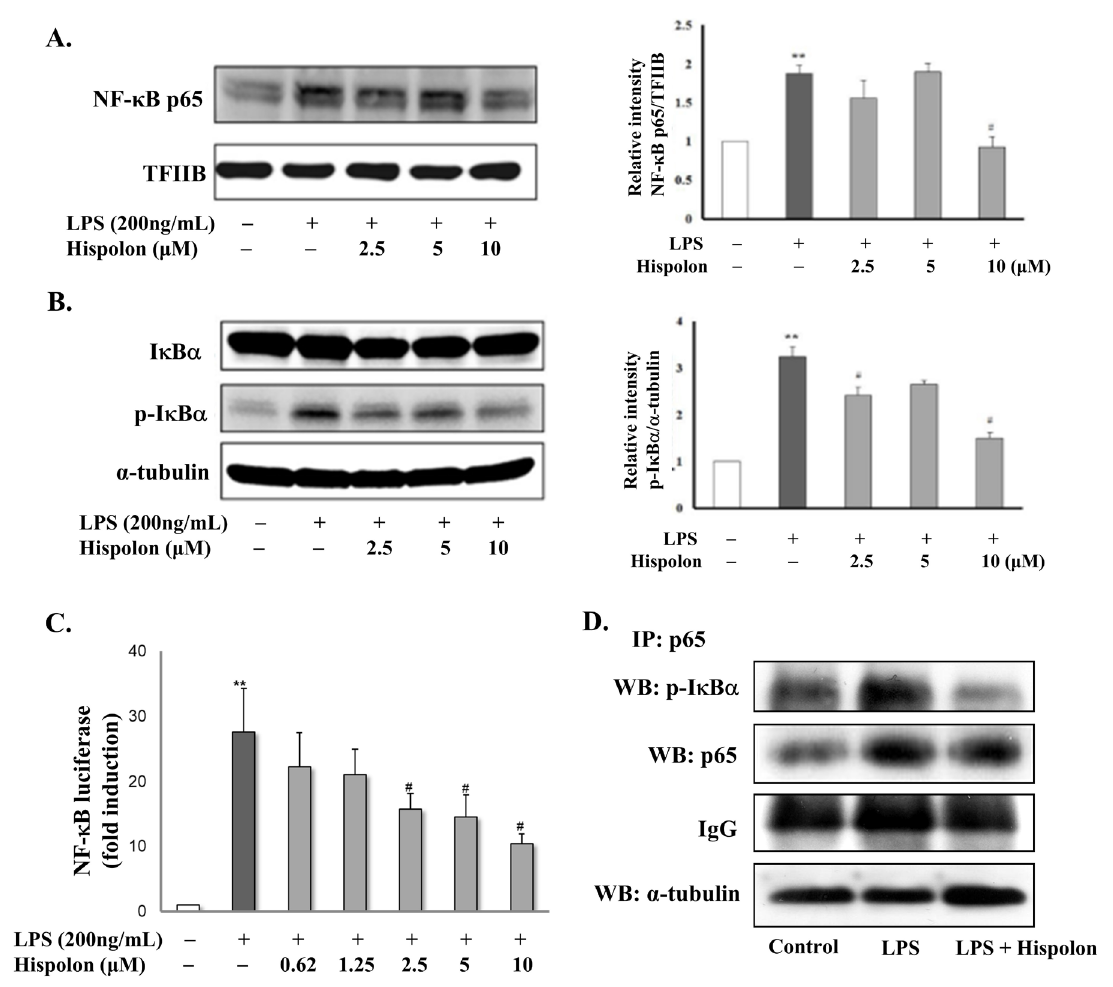
Figure 4. Hispolon decreased NF- κ B activity in LPS-treated RAW264.7 cells. Cells were pretreated with hispolon for 1 h and then stimulated with LPS for 1 h to examine protein levels. ( A ) The nuclear fraction and ( B ) cytoplasmic fraction were prepared for Western blotting analysis. ( C ) Cells were transfected with a construct containing an NF- κB response element and a luciferase reporter gene and then incubated for 24 h. The transfected cells were treated with hispolon for 1 h prior to LPS stimulation. Luciferase activity was measured in the cell lysates. ( D ) Whole-cell lysates were prepared, and a coimmunoprecipitation assay was performed to identify NF- κB p65 and phospho - IκBα protein complexes. The data are presented as the means of three separate experiments performed in triplicate ( n = 3). The relative intensity of the band in each blot was quantified using ImageJ software. Significance was analyzed using one-way ANOVA; ** p < 0.01, vs. control group; # p < 0.05, vs. LPS-treated group.